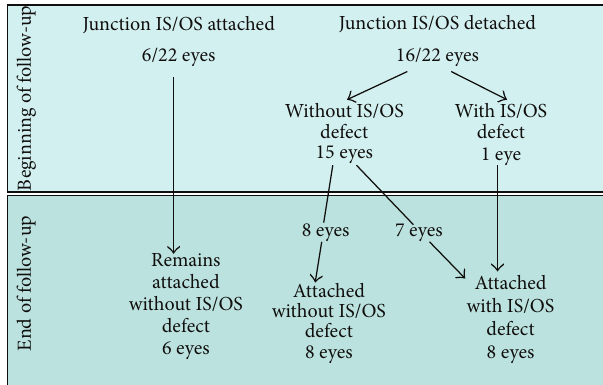
Scheme 1: Follow-up results of patients treated with RHF.